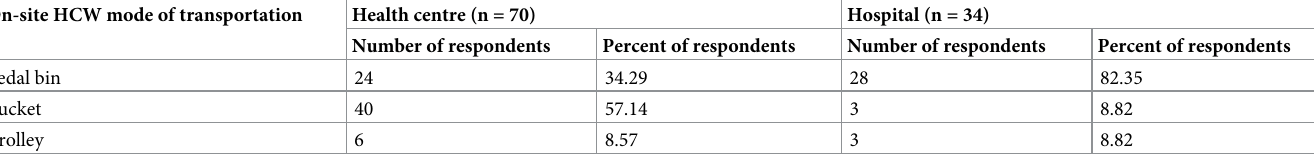
Table 11. Managers response to mode of on-site transportation used in the study health facilities, Addis Ababa City Administration, February 2018. On-site HCW mode of transportation